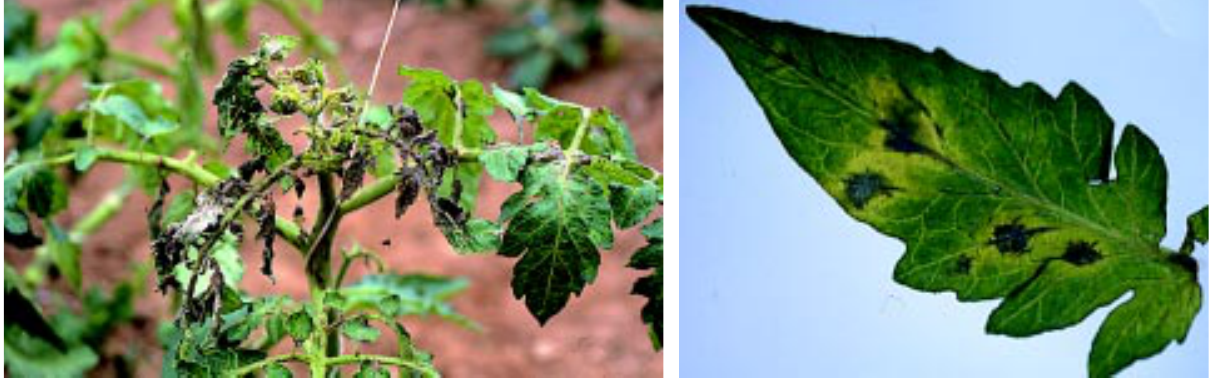
Fig. 1. Tomato plant infected with TSWV showing necrosis in the main stem.